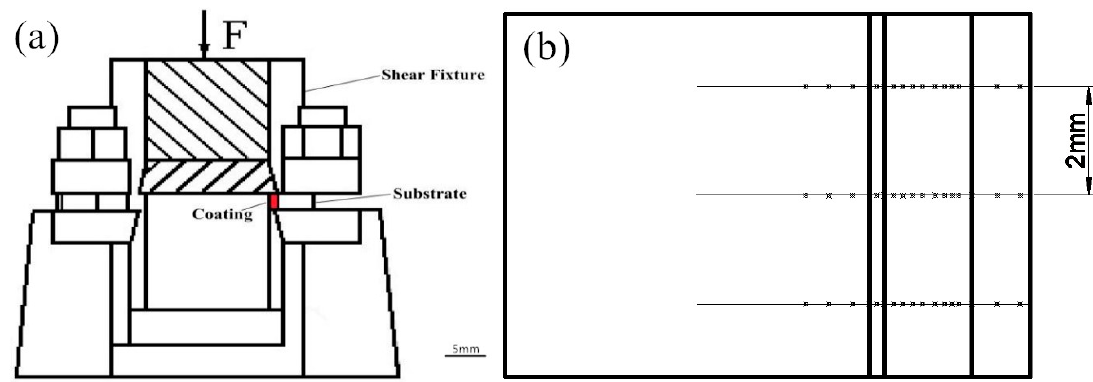
Figure 5. ( a ) Shear test schematic; ( b ) microhardness test diagram.